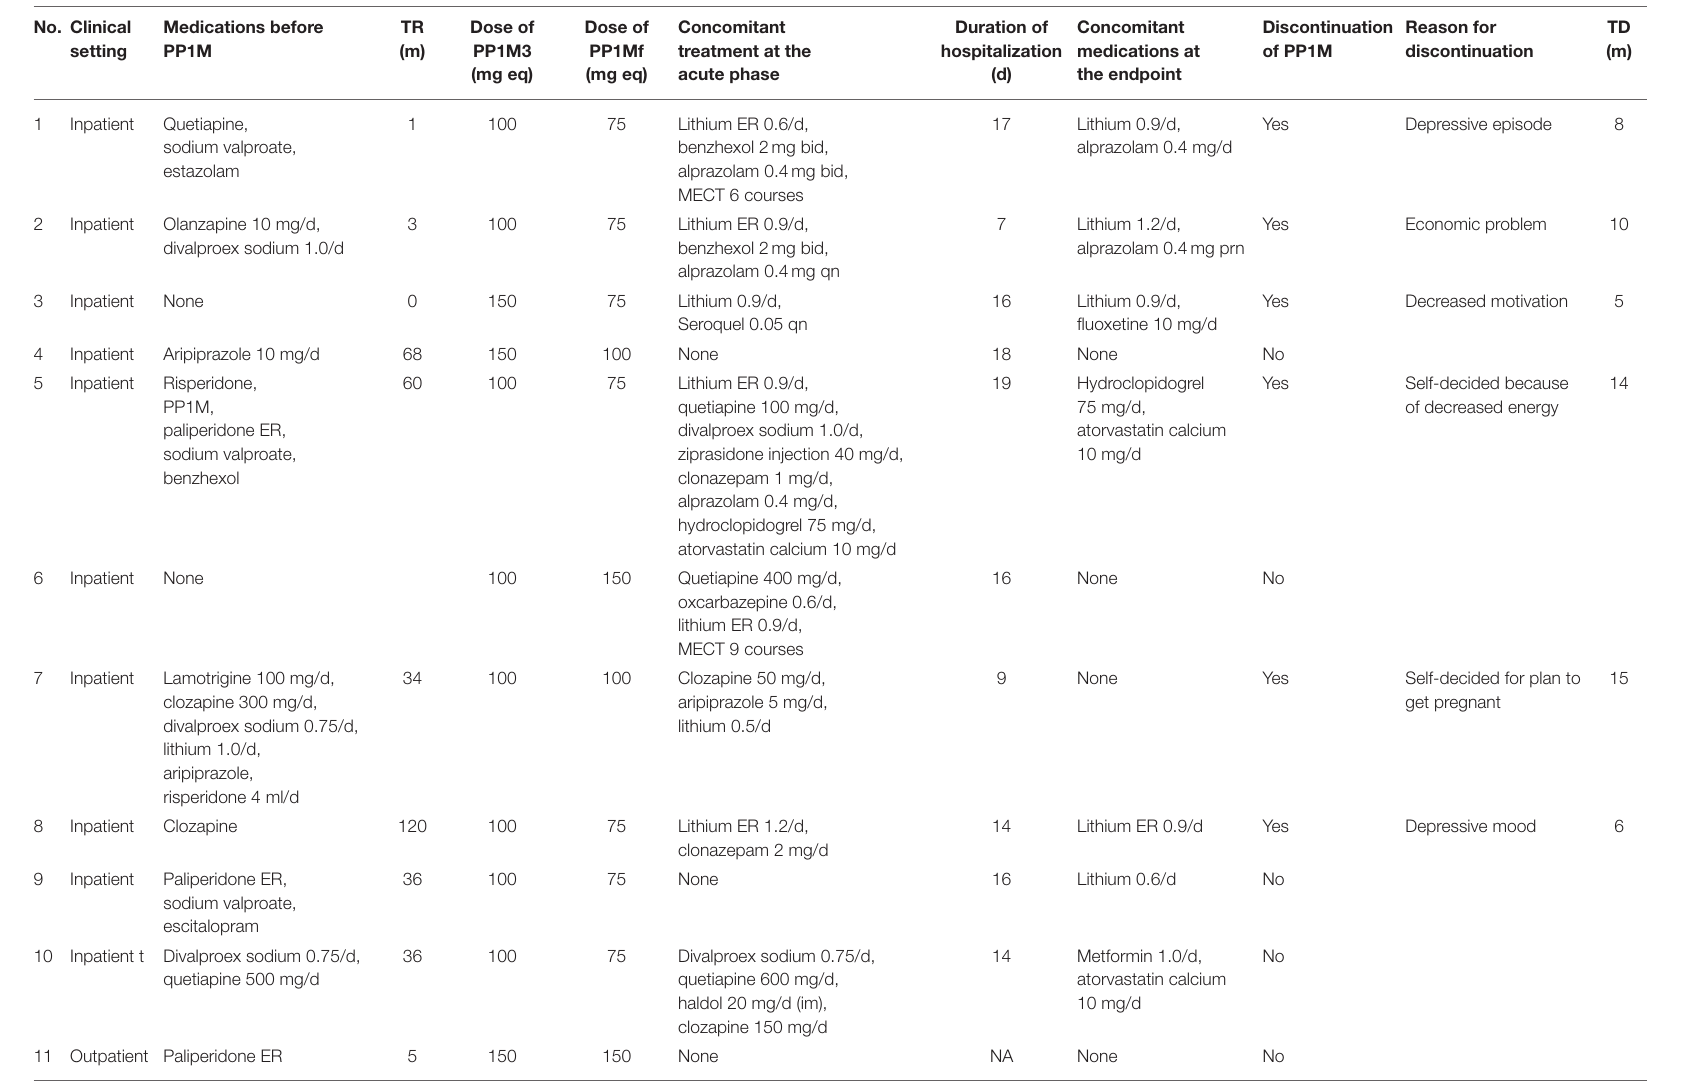
TABLE 2 | Treatment of all the participants. No. Clinical